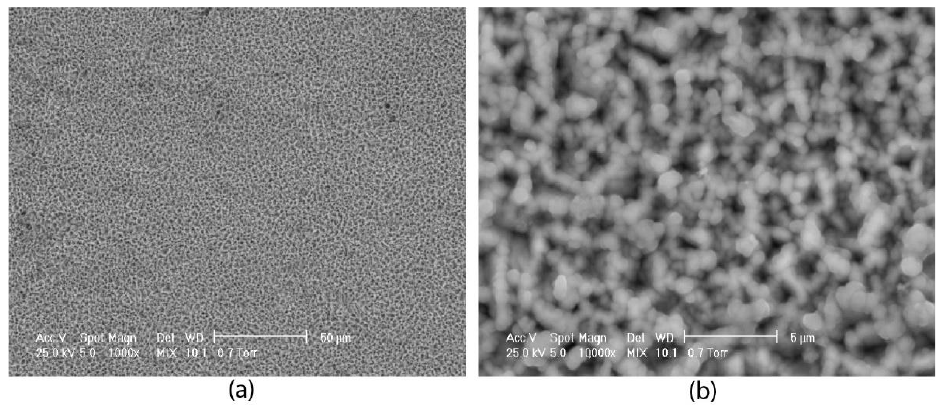
Figure 12. SEM morphology of the non-equimolar CoCrFeMnNi thin film, sample 2: ( a ) ×1000; ( b ) ×10,000.